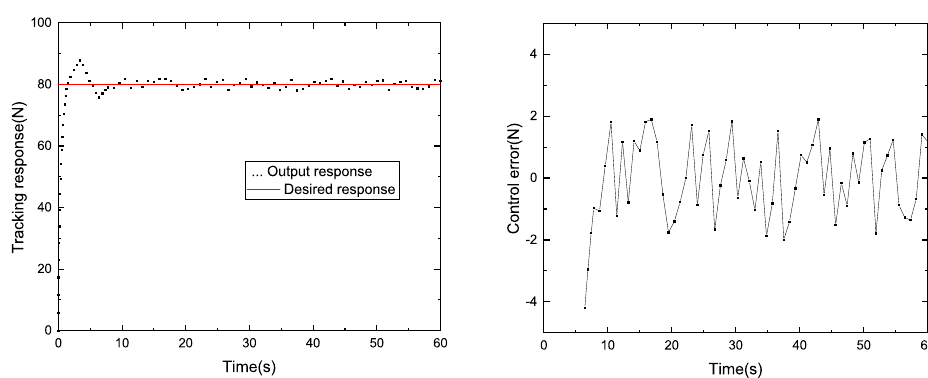
Figure 7. Tracking response and control error